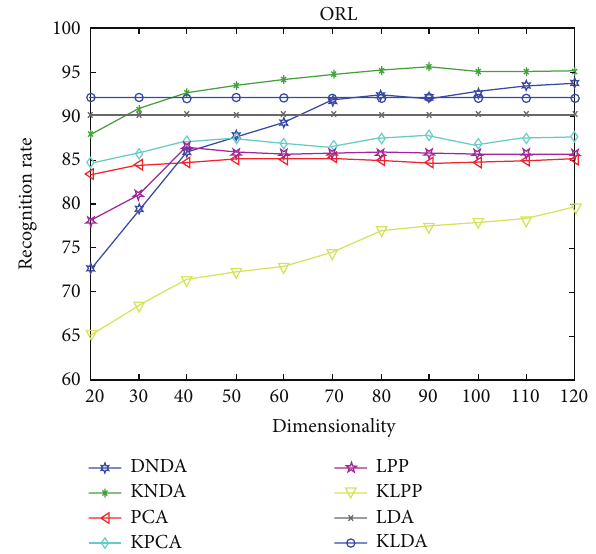
Figure 9: The recognition rates versus the subspace dimension on ORL